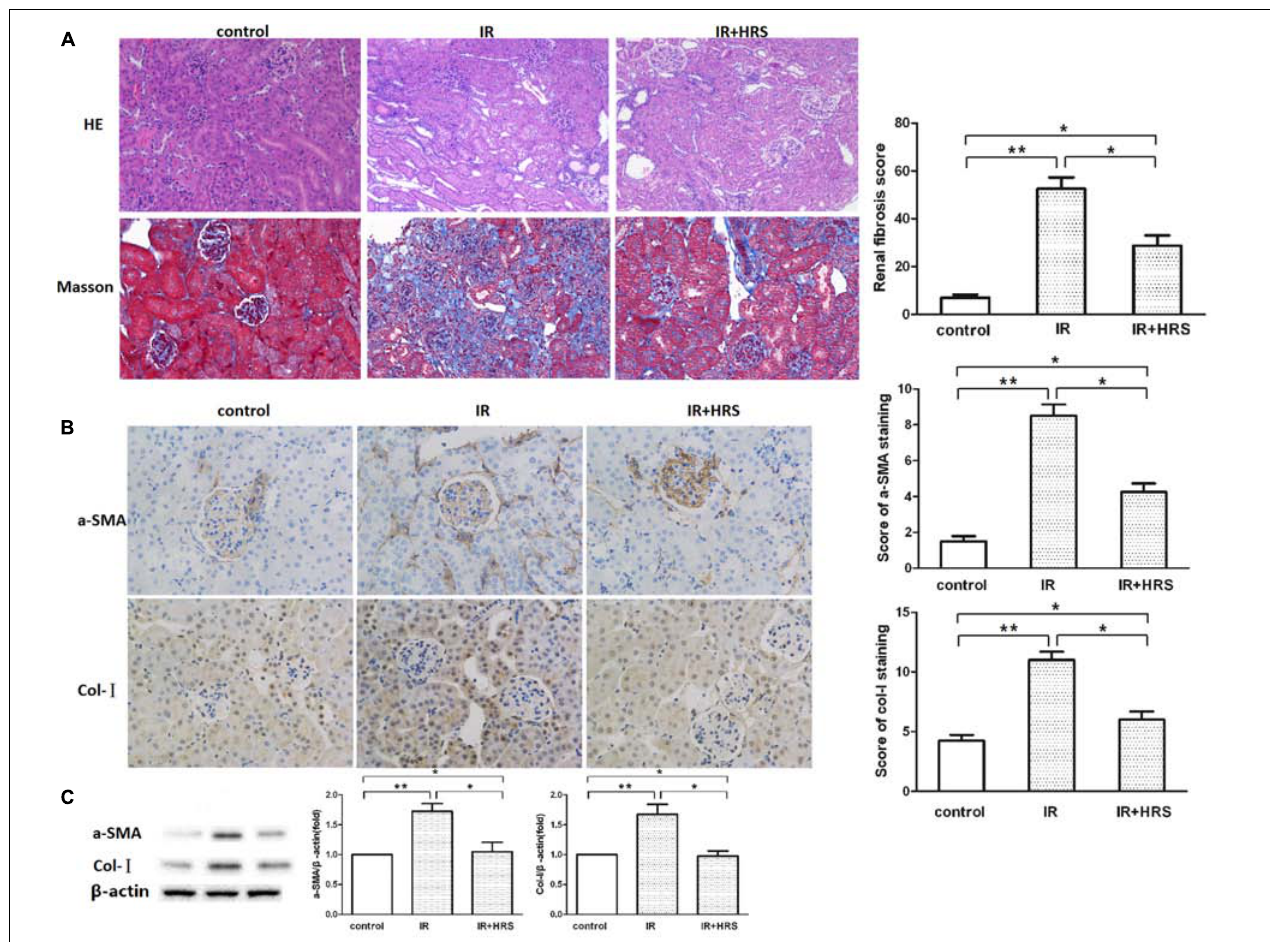
FIGURE 1 | HRS Reduces the Histopathologic Damage in Mice with IR injury. (A) Representative photomicrographs of renal tissues submitted to hematoxylin-eosin and Masson Trichrome staining (200 × magnification). Renal fibrosis scores provided semi-quantitative data of Trichrome staining findings. (B,C) Changes of fibrotic a-smooth muscle actin (a-SMA) and collagen I (Col I) levels by immunoblot were consistent with Trichrome staining data, with robustly increased amounts in IR models. ∗ P < 0.05, ∗∗ P < 0.01.